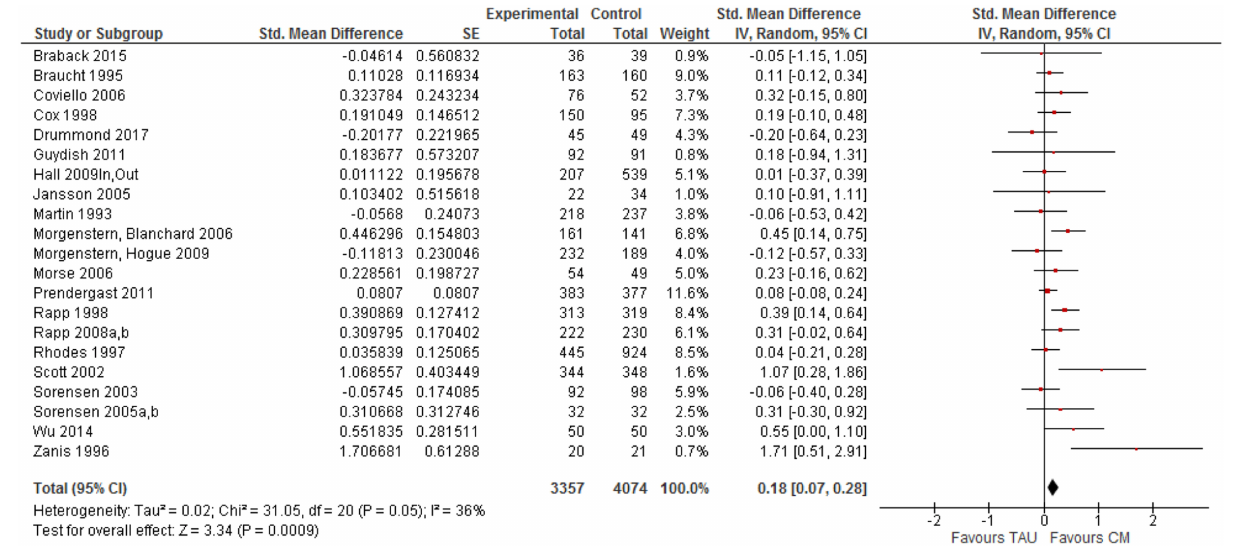
(SMD = 0.17, 95% CI [ − 0.04, 0.38]), retention in